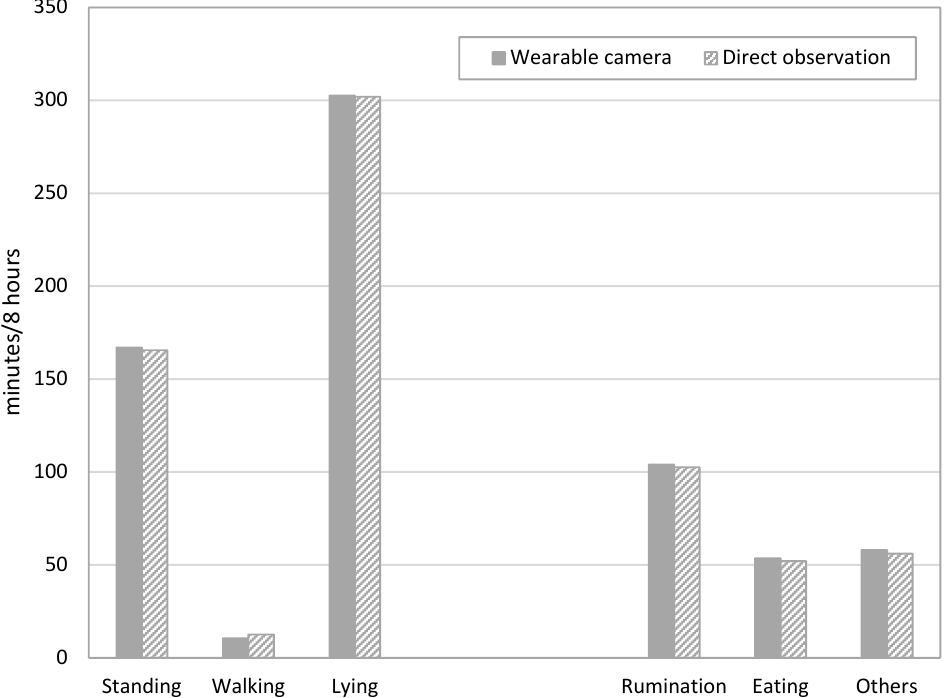
Figure 4. Total observation time for the different calf postures and behaviors, and the corresponding time between direct and wearable camera observations during the study investigating the suitability of wearable cameras for monitoring juvenile bovine behavior.